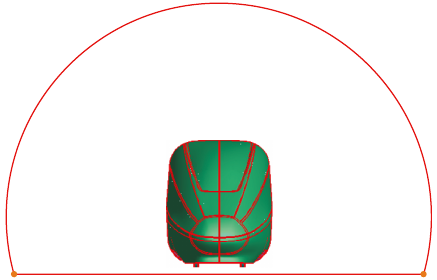
Figure 2: Computational